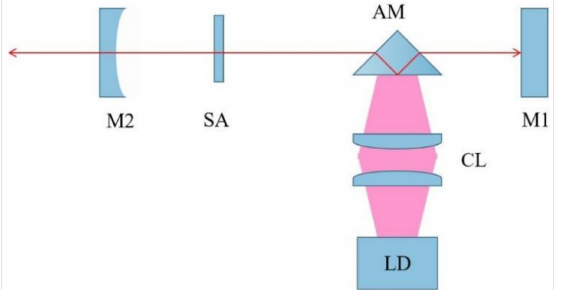
Figure 5. Arrangement of the laser resonator with side-pumped trigonal crystal (LD, fast-collimated pumping laser diode; CL, coupling lens; AM, triangular slab active medium; SA, V:YAG; M2, laser output coupler; M1, laser rear